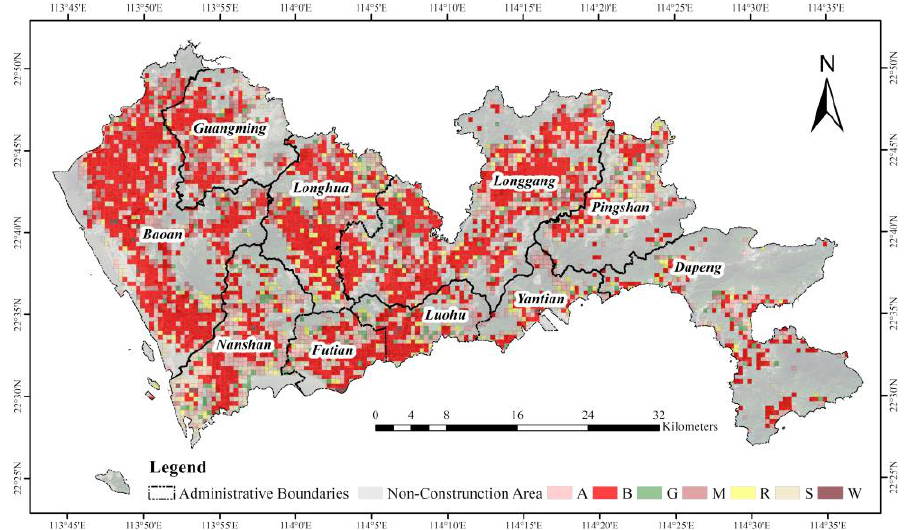
Figure 4. The main type of functional construction land zone recognition results at a 500 m grid scale. A: Administration and public services function; B: Business services function; G: Green spaces and squares function; S: Street and transportation function; M: Manufacture function; R: Residential function; W: Warehousing and logistics